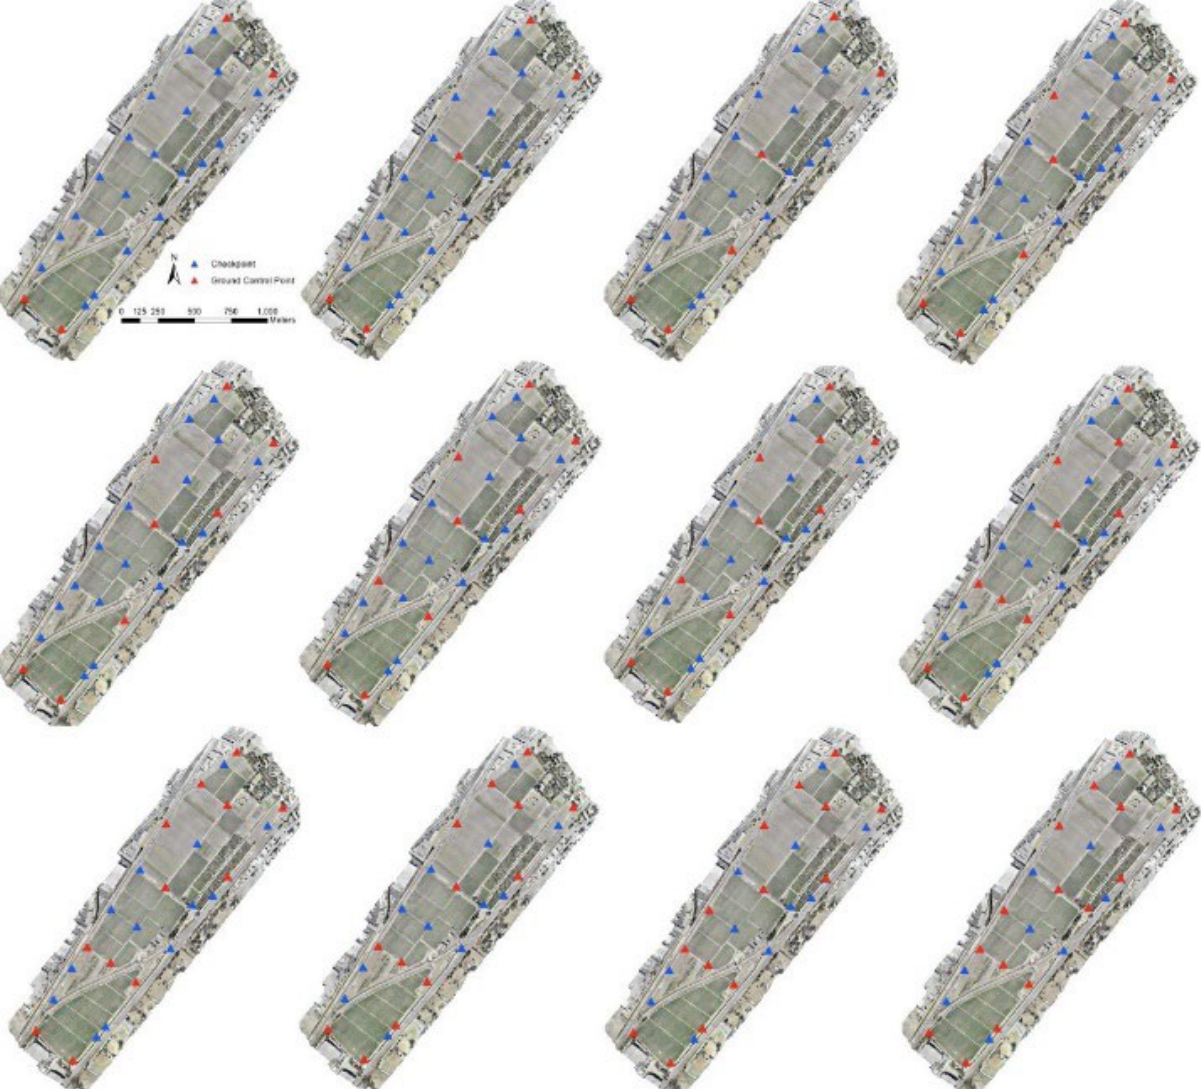
Figure 3 . Twelve experimental tests were evaluated with varying distribution of GCPs and